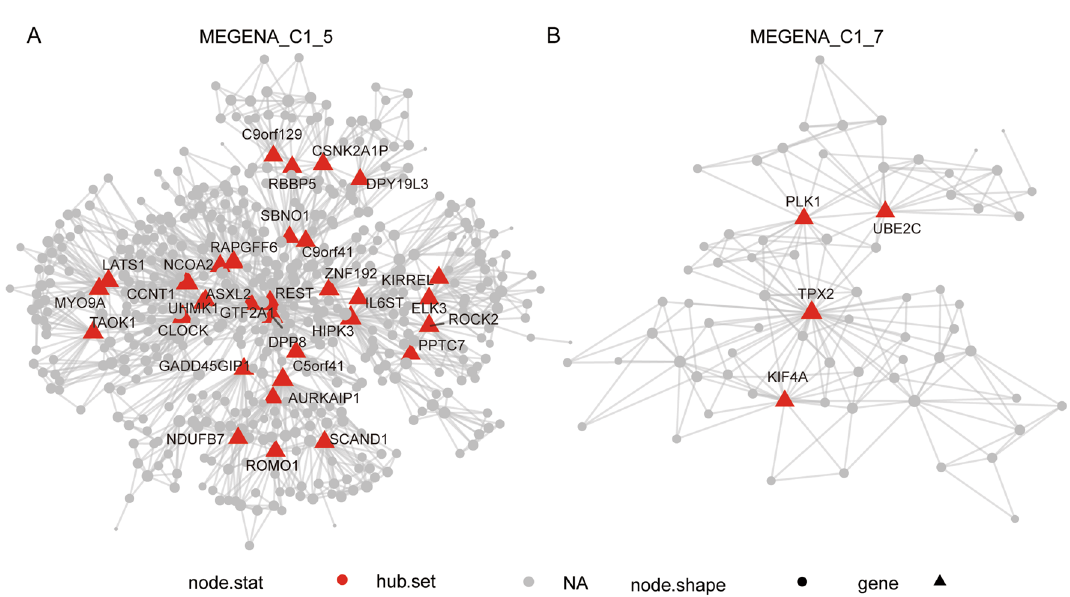
Figure 6. Visualization of interest modules and hub genes multiscale embedded gene co-expression network analysis (MEGENA). ( A ). Intergenic connectivity of genes in MEGENA_C1_5 and identification of key genes. ( B ). Intergenic connectivity of genes in MEGENA_C1_7 and identification of key genes. The red triangle represents the HUB gene and the gray circle represents the non-core